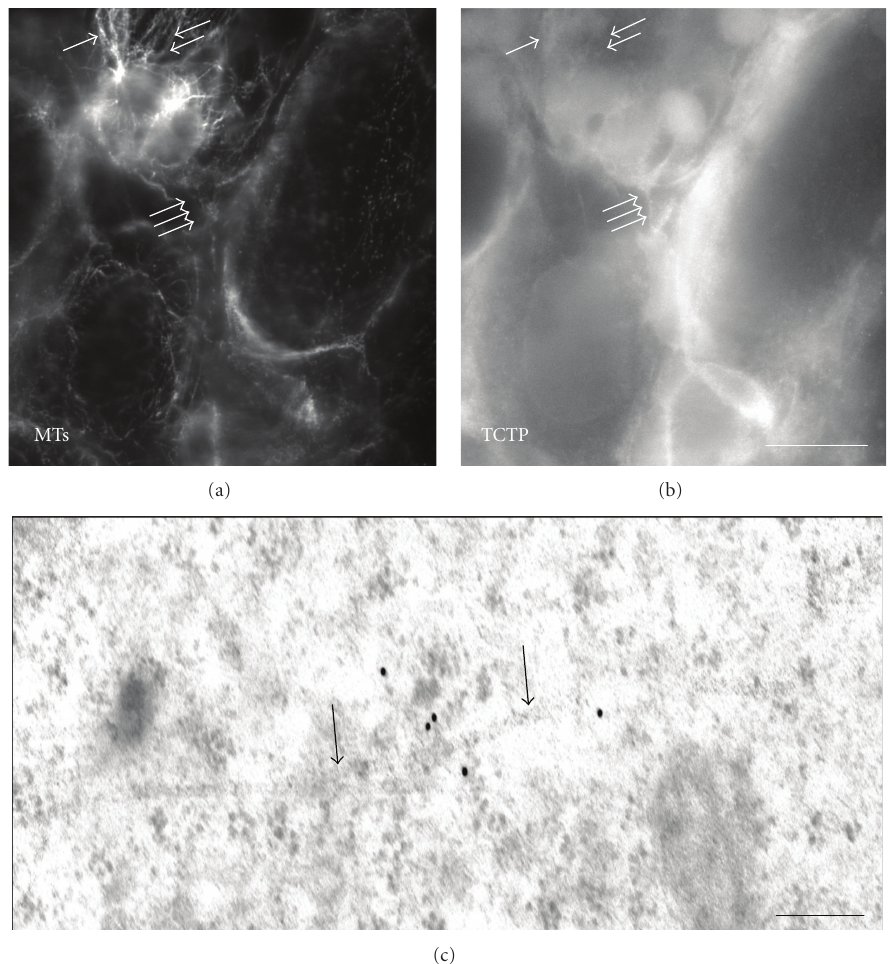
Figure 4: MTs and TCTP in Xenopus laevis tadpole ovary. Interphase cells. Upper panel, left: β -tubulin, right: TCTP localization. Anti- XlTCTP was used for this localization. Single white arrow points to cellular structures positive both for β -tubulin and TCTP. Double arrows point to β -tubulin-positive and TCTP-negative fibers. Triple arrows point to TCTP-positive and β -tubulin-negative fibers. Bar is equal to 20 μ m; Bottom panel: electron microscopy gold immunolabeling of TCTP (black particles in the center) in the vicinity of MTs (black arrows). Bar is equal to